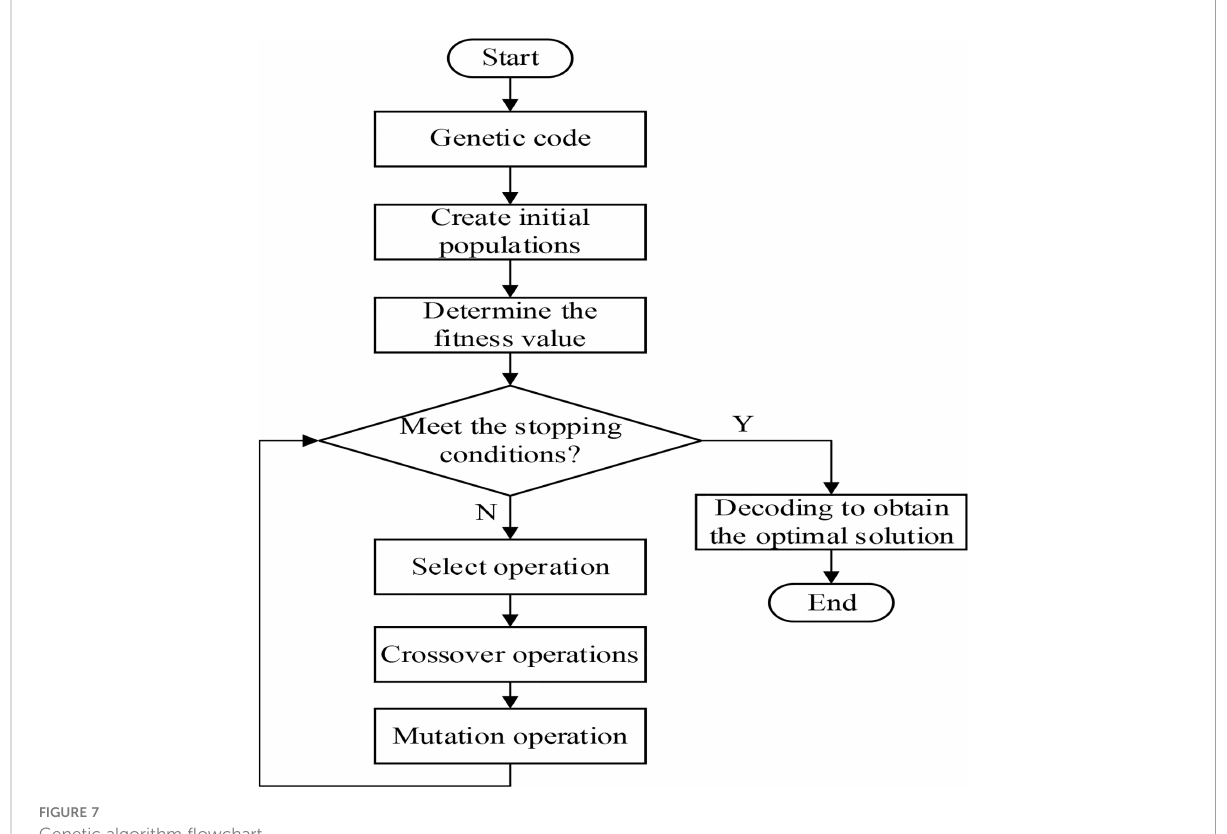
FIGURE 7 Genetic algorithm fl